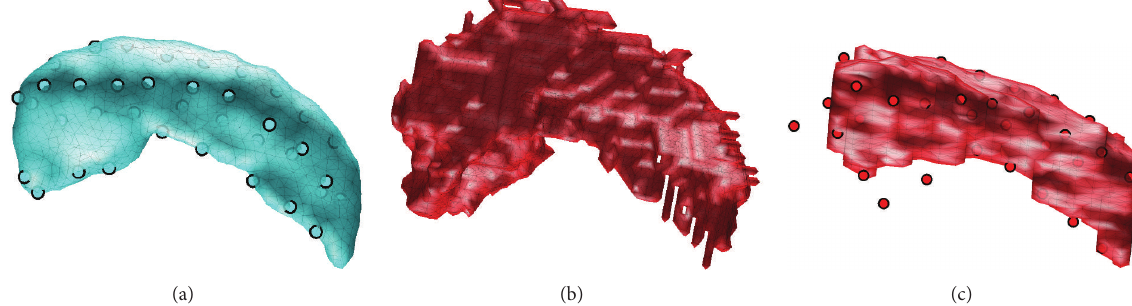
Figure 1: (a) Template hippocampus for ADNI dataset. (b) Hippocampus isosurface from example volumetric parcellation. (c) Isosurface of example hippocampus manual segmentation for our landmark datasets.